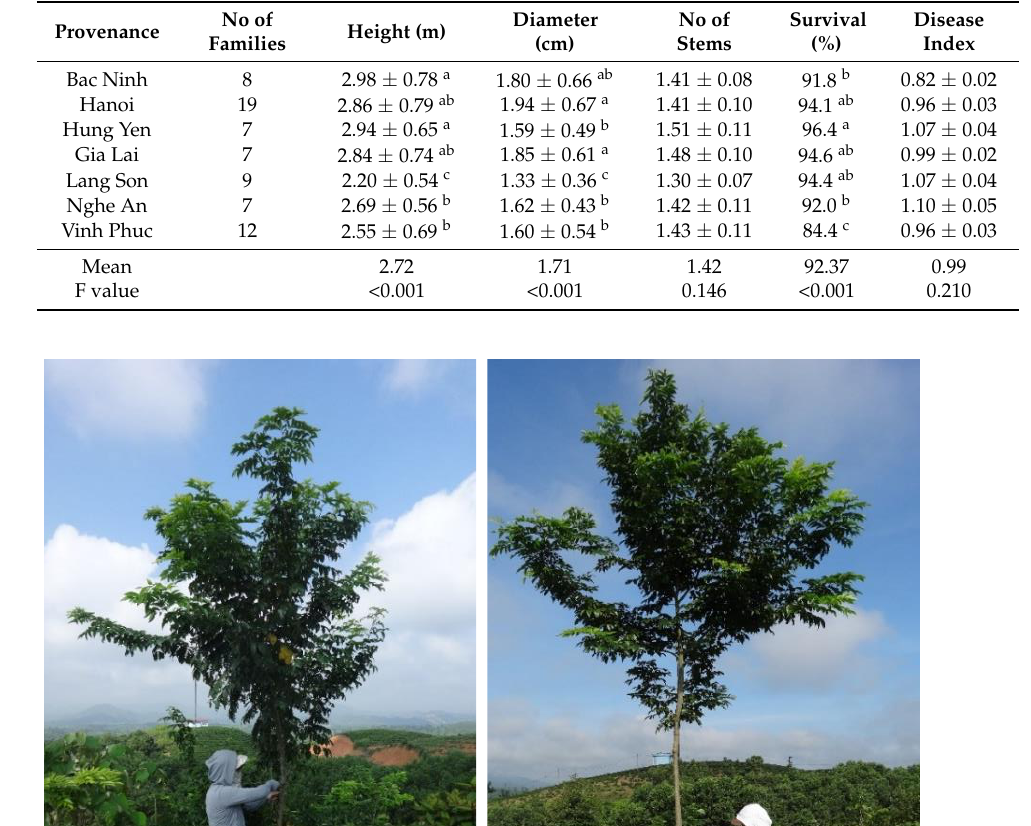
Table 2. Average height, diameter, number of stems, survival, and disease index of Dalbergia tonkinensis provenances at 3 years in Doan Hung. Different lowercase letters in a column indicate a significant difference according to DMRT at p < 0.05.